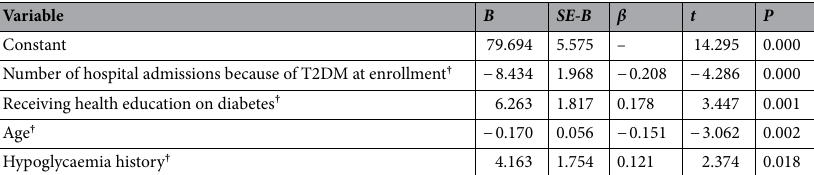
Table 5. Factors related to fear of hypoglycaemia among type 2 diabetic patients ( n = 385). B, unstandardized coefficient beta; SE-B, standard error of B; β, standardized coefficient beta; T2DM, type 2 diabetes mellitus. † Number of hospital admissions because of T2D at enrollment: 1 = First time, 2 = Second time or